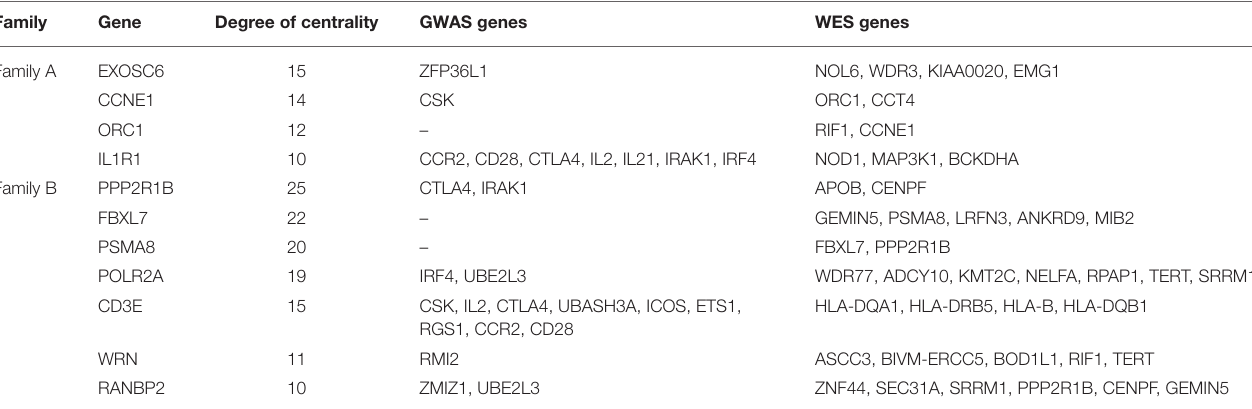
TABLE 2 | Degree centrality between hub genes with GWAS loci and WES mapped genes with rare variants.